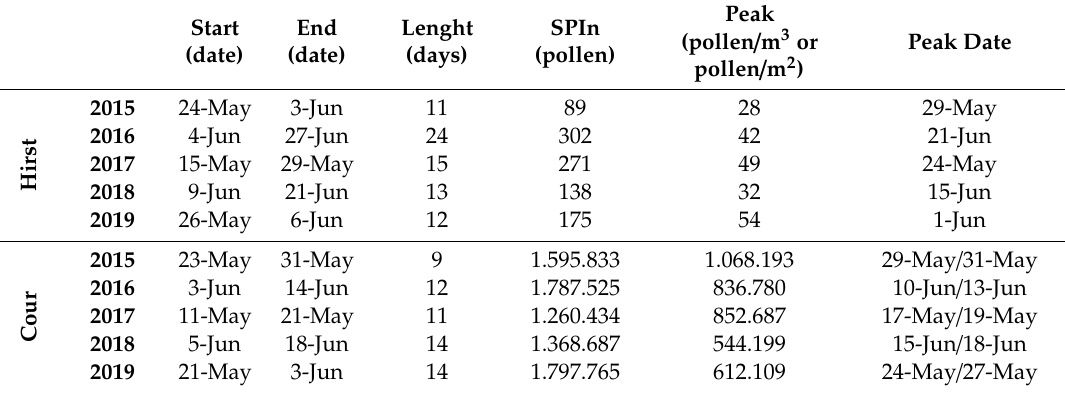
Figure 3. Vitis vinifera L. pollen concentration during the study years, Hirst pollen (brown line), Cour pollen (blue line), maximum temperature (discontinuous black line) and rainfall in bars. Phenological stage 6 (flowering) with tree phenophases 61: Beginning of flowering: 10% of flower caps fallen, 65: Full flowering: 50% of flower caps fallen and 69: End of flowering. Cultivars A: ‘Albariño’, L: ‘Loureira’, G: ‘Godello’, and T: ‘Treixadura’. ( a ) 2015 data ( b ) 2016 data ( c ) 2017 data ( d ) 2018 data ( e ) 2019 data. Table 2. Date of the start and end of the main pollen season (MPS), length of the main pollen season (MPS) (days), seasonal pollen integral (SPIn) (pollen), pollen peak (pollen / m 3 ) (pollen / m 2 and date of the pollen peak (day).